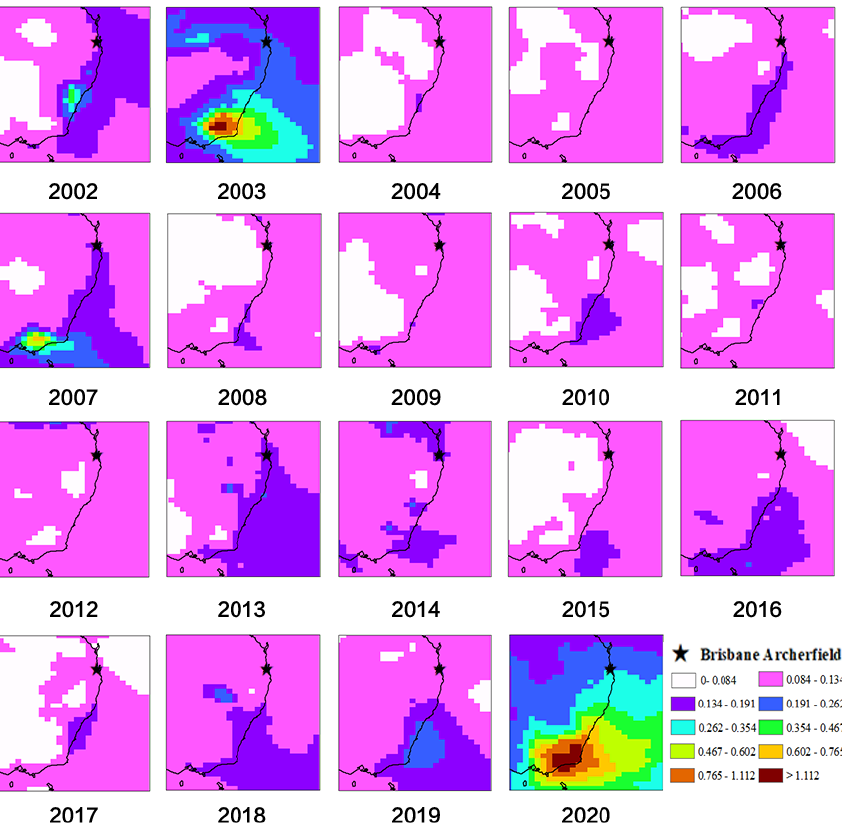
Figure 8. The spatial distribution of aerosol optical depth (AOD) of total aerosols in eastern Australia during January from 2002 to 2020 using the Modern-Era Retrospective analysis for Research and Applications version 2 (MERRA-2) AOD